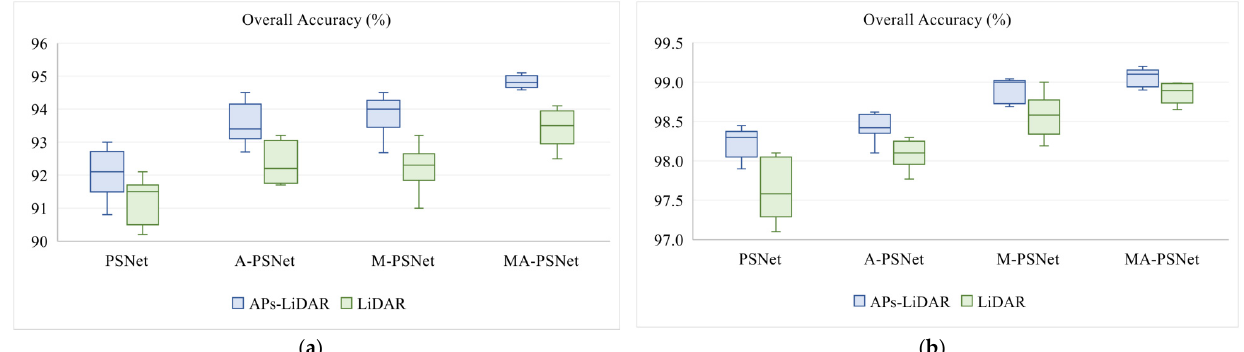
Figure 11. Comparison of classification accuracy before and after adopting the Aps on two datasets ( a ) Houston dataset. ( b ) Trento dataset.